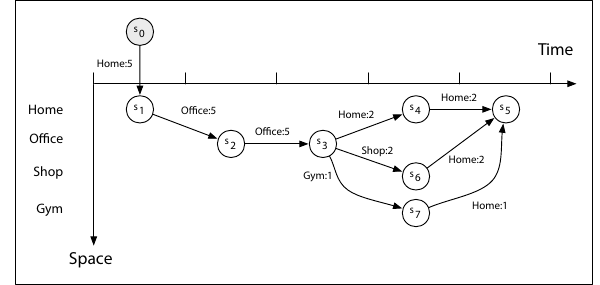
Figure 2: Example of finite state machine.